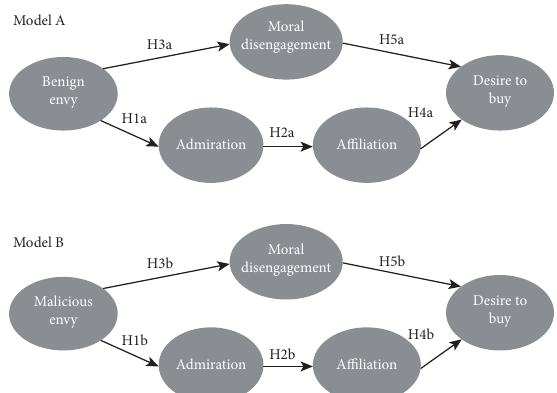
Figure 1: Schematic diagram of the concept model of envy and desire for luxury